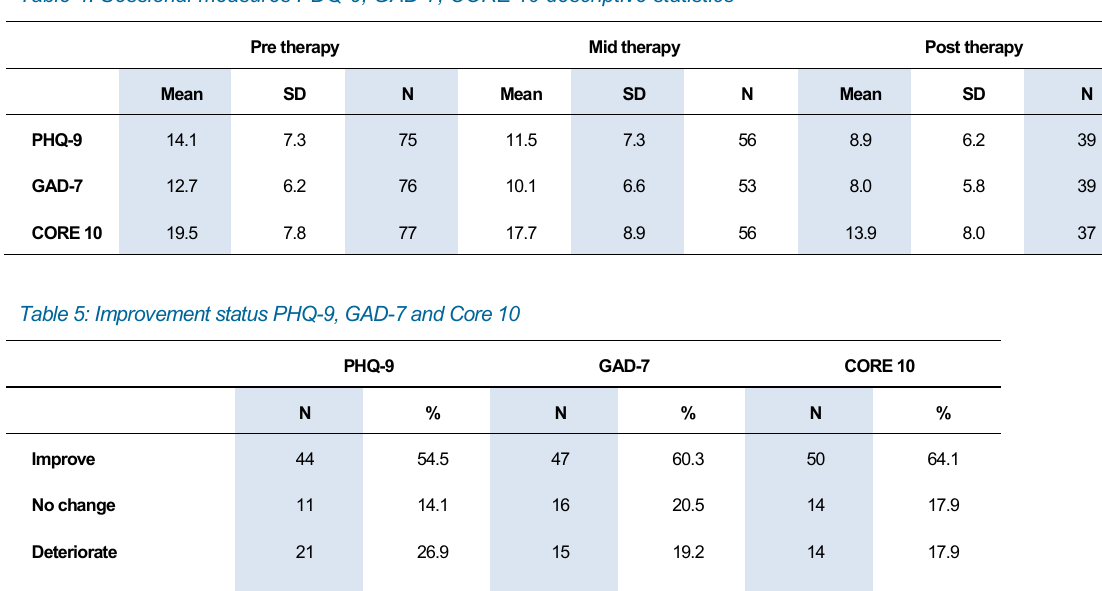
Table 4: Sessional measures PDQ-9, GAD-7, CORE 10 descriptive statistics